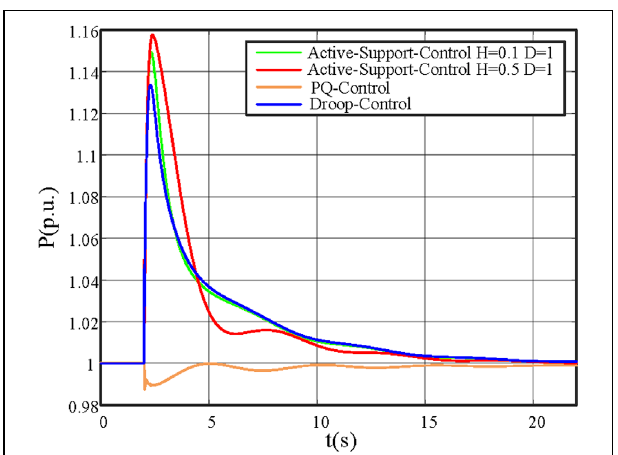
FIGURE 5 | Active power output of different control